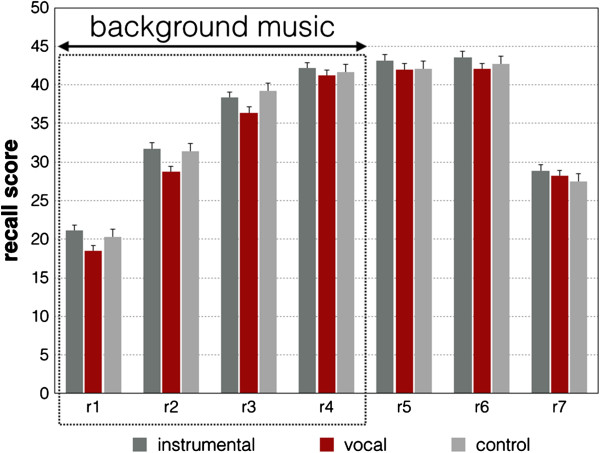
Average recall performance (and standard errors of the mean) for the 7 recall stages (r1-r7) broken down for the three groups (control, vocal, and instrumental music). Recall 5 (r5) and recall 6 (r6) were conducted 10 and 30 minutes after recall 4 (r4). Recall 7 (r7) was conducted 2 weeks after the experiment. The participants of the vocal and instrumental groups received background music stimulation during the learning sessions r1-r4. The recall scores presented here are adjusted for psychometric intelligence.